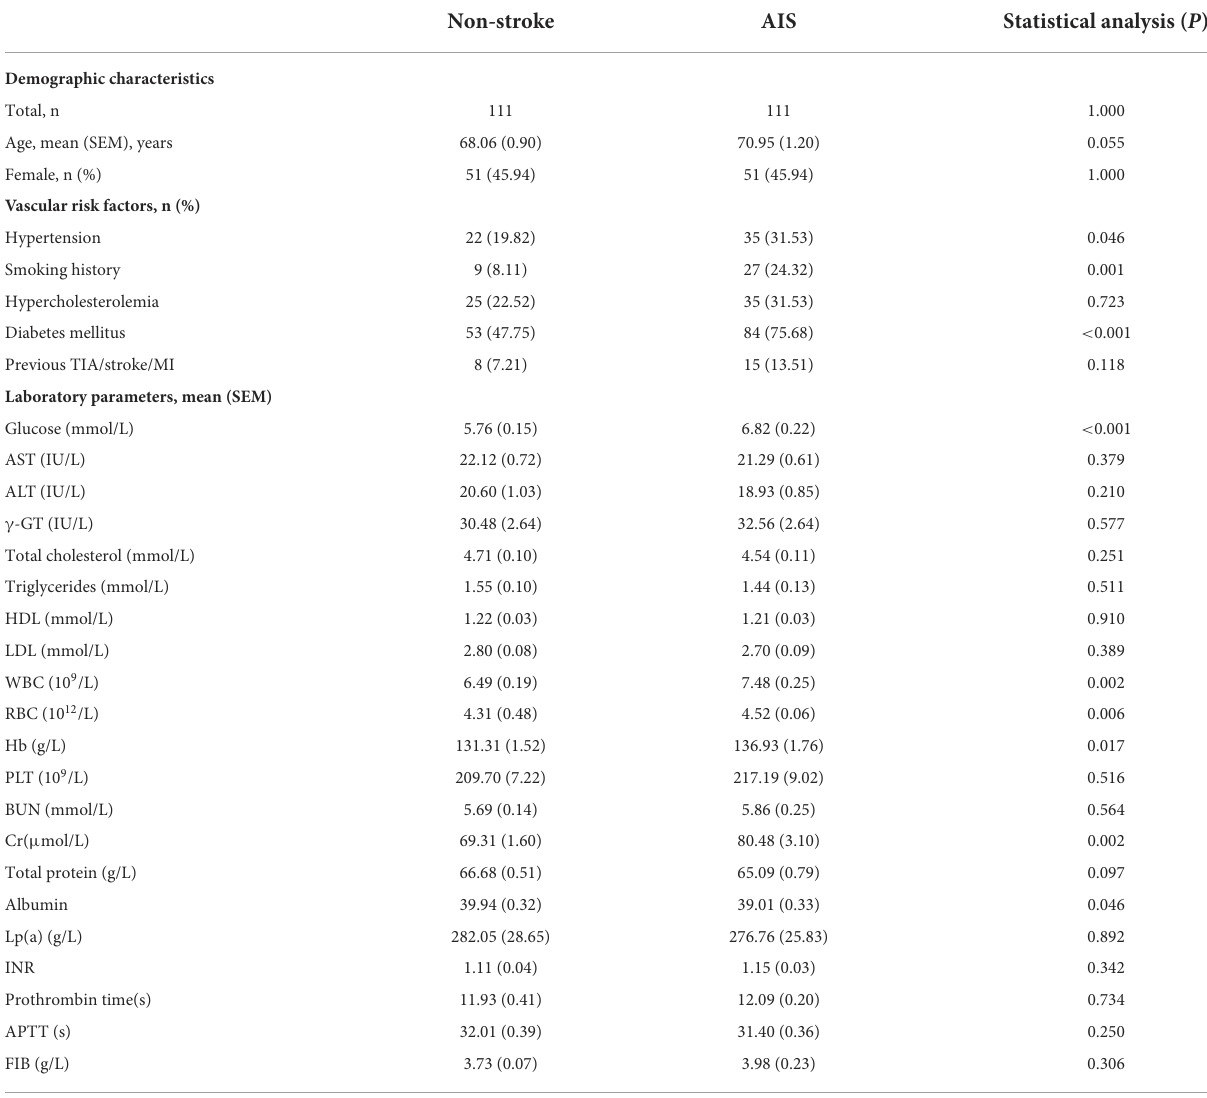
TABLE 1 Demographic and clinical characteristics of stroke and non-stroke